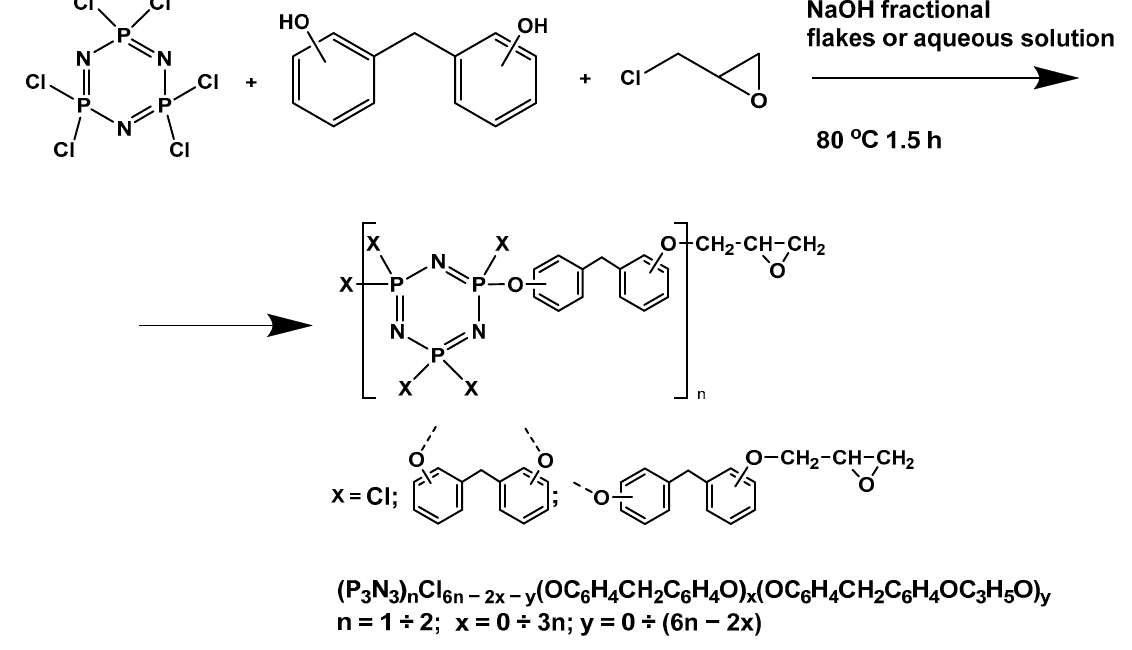
Figure 1. Single-stage synthesis of phosphazene-containing epoxy resins by direct interaction of hexachlorocyclotriphosphazene (HCP) and bisphenol F in epichlorohydrin medium (this work). 2.1. Materials Hexachlorocyclotriphosphazene (HCP), a white crystalline substance (T m.p. = 113.0 °C; 31 P NMR spectrum, singlet with δ P = 19.9 ppm), was obtained by the method in [56]. Bisphenol F (BPF), a white powder (mixture of isomers 2,2 ′ -, 2,4 ′ -, and 4,4 ′ -dioxydi- phenyldimethylmethane, T m.p. = 162–164 °C) (Manufacturer: Hangzhou Sartort Biopharma Co., Ltd., Hangzhou, China). Epichlorohydrin (ECH) is a colorless liquid, the content of the main substance is 99.8%, and it was used after preliminary distillation, Т b.p. = 116 ° С (Manufacturer: Solvay, Tavaux, France). Potassium hydroxide, in the form of white flakes (the content of the main substance is 90%), was used without purification. The water content was determined by acid-base titration and was about 10% (Manufacturer: JSC “Caustic” Volgograd, Russia). Acetone is a colorless liquid, and the content of the main substance is 99.8%. It was used as a solvent during isolation without preliminary purification (Supplier: Compo- nent-Reaktiv LLC, Moscow, Russia). Diglycidyl ether of bisphenol A (DGEBA) is a clear-cloudy viscous liquid at room temperature. Commercial-grade KER 828 was used without pre-treatment (Manufacturer: Kumho P & B Chemicals, Inc., Seoul, South Korea). Diglycidyl ether of bisphenol F (DGEBF) is a clear-cloudy viscous liquid at room tem- perature. The commercial brand Ipox er 1016 was used without preliminary purification (Supplier: NORTEX LLC, Moscow, Russia). Diaminodiphenylsulfone (DDS) (Aradur 9664-1) is a fine powder with a particle size smaller than 64 μ m and Т m.p. = 175 ° С (Manufacturer: Huntsman Corporation, Spain).